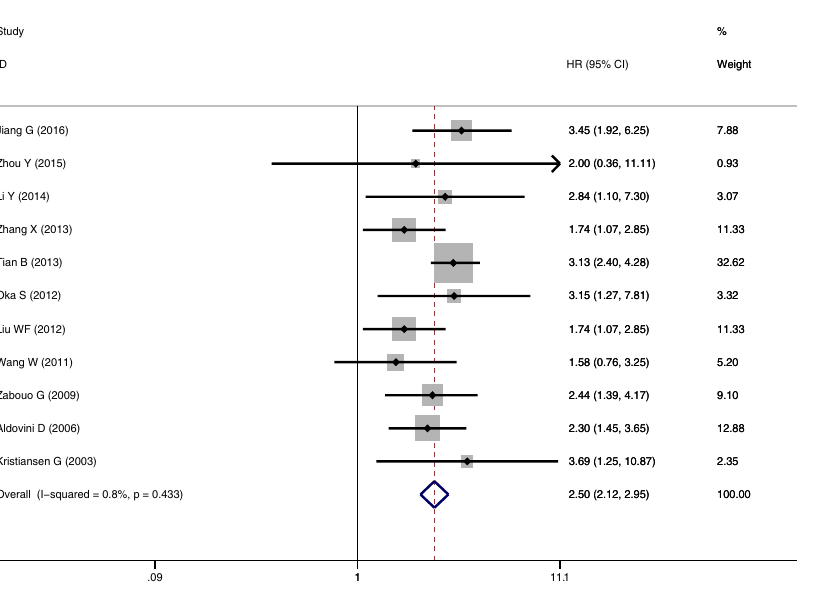
Figure 2. The correlation between CD146 expression and overall survival (OS) in solid